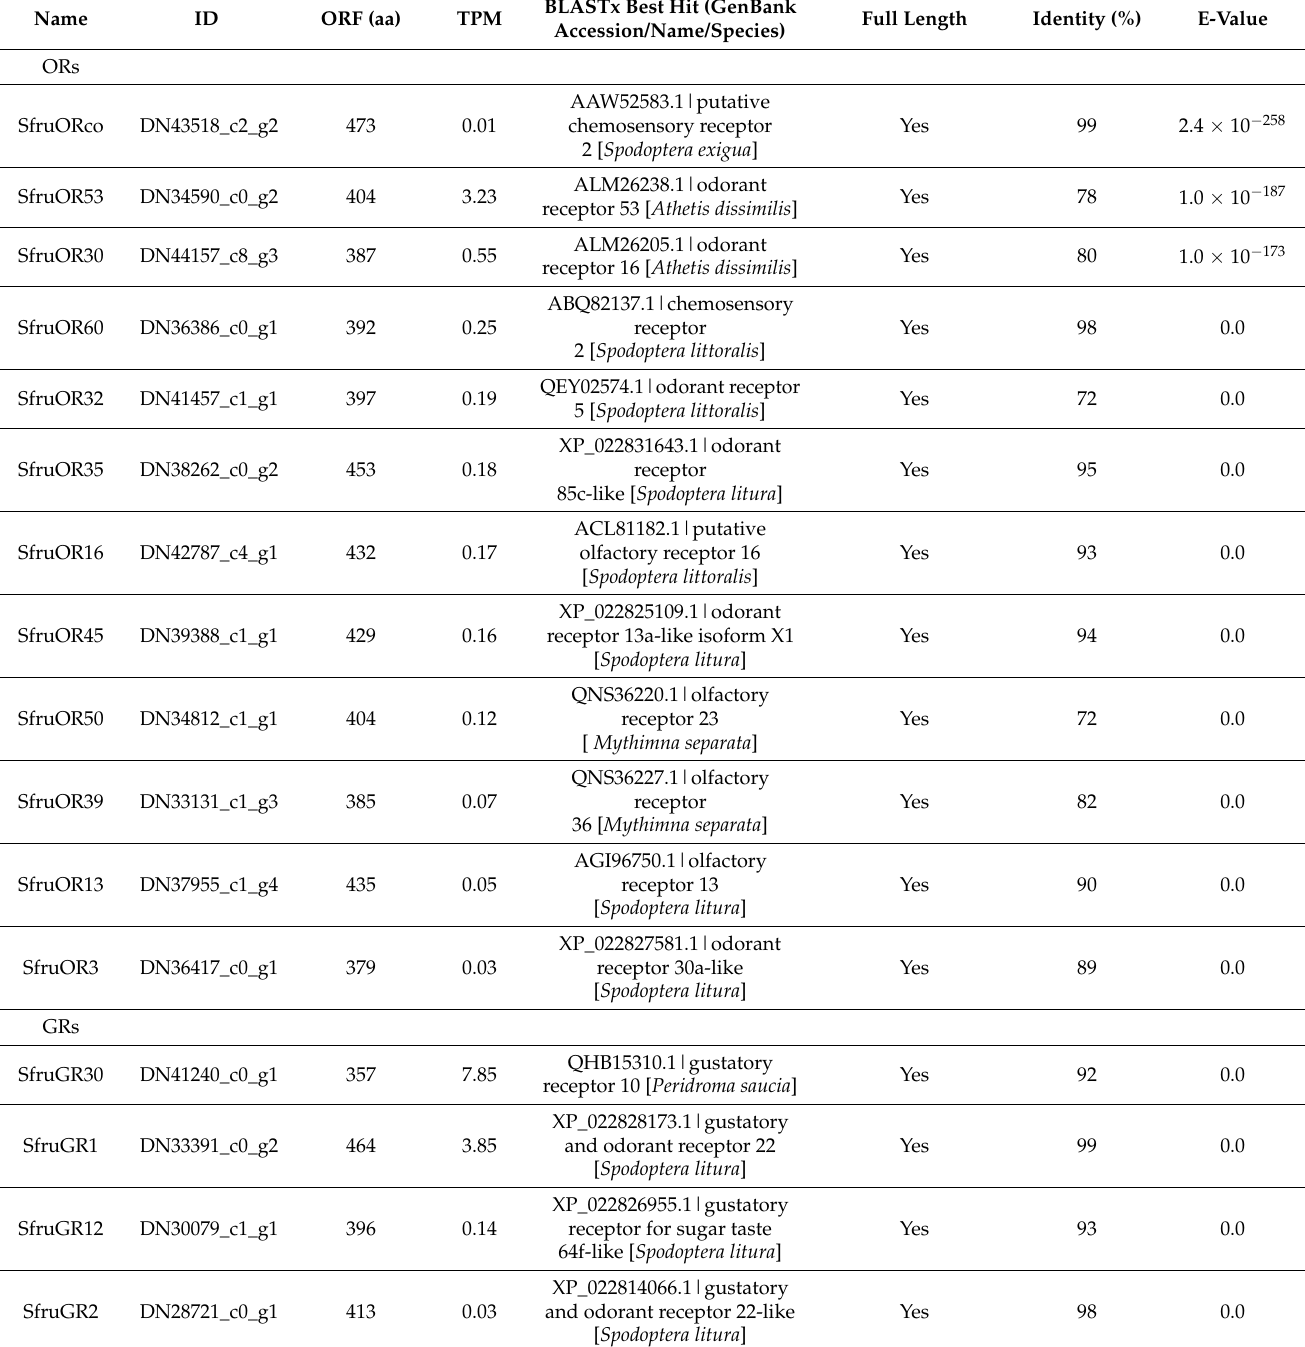
Unigenes of candidate chemosensory receptors in pheromone gland-ovipositor of S. frugiperda